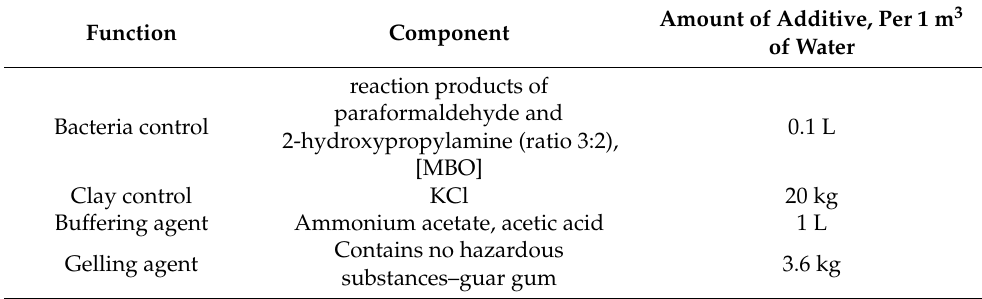
Table 1. Composition of the fracturing fluid used at the second stage of well stimulation.